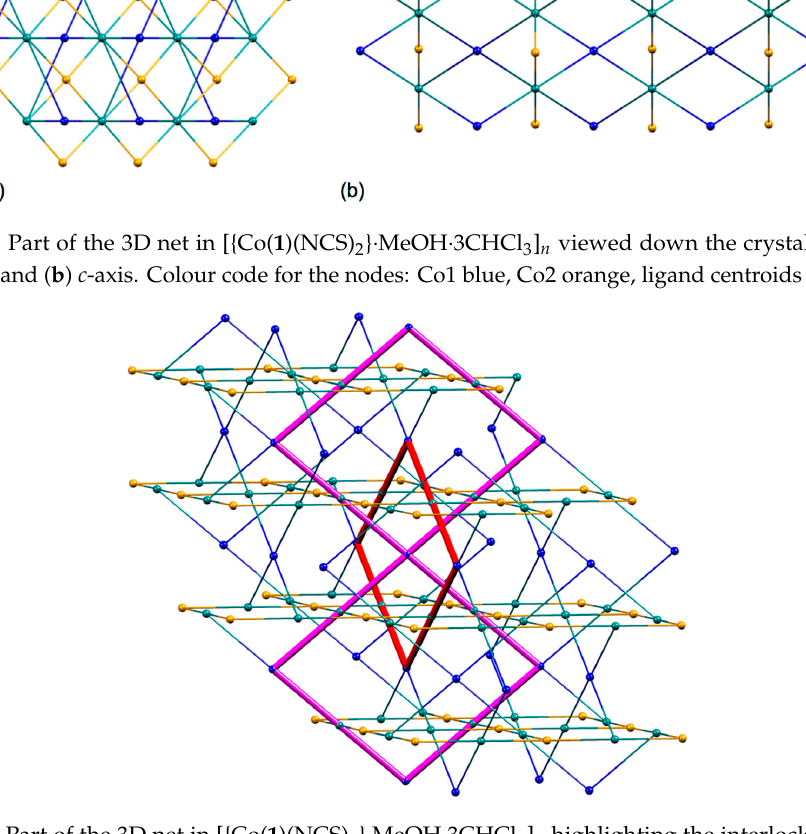
Figure 6. Part of the 3D net in [{Co( 1 )(NCS) 2 } · MeOH · 3CHCl 3 ] n highlighting the interlocking of the shortest circuits (shown in red and magenta). Colour code for the nodes: Co1 blue, Co2 orange, ligand centroids green.